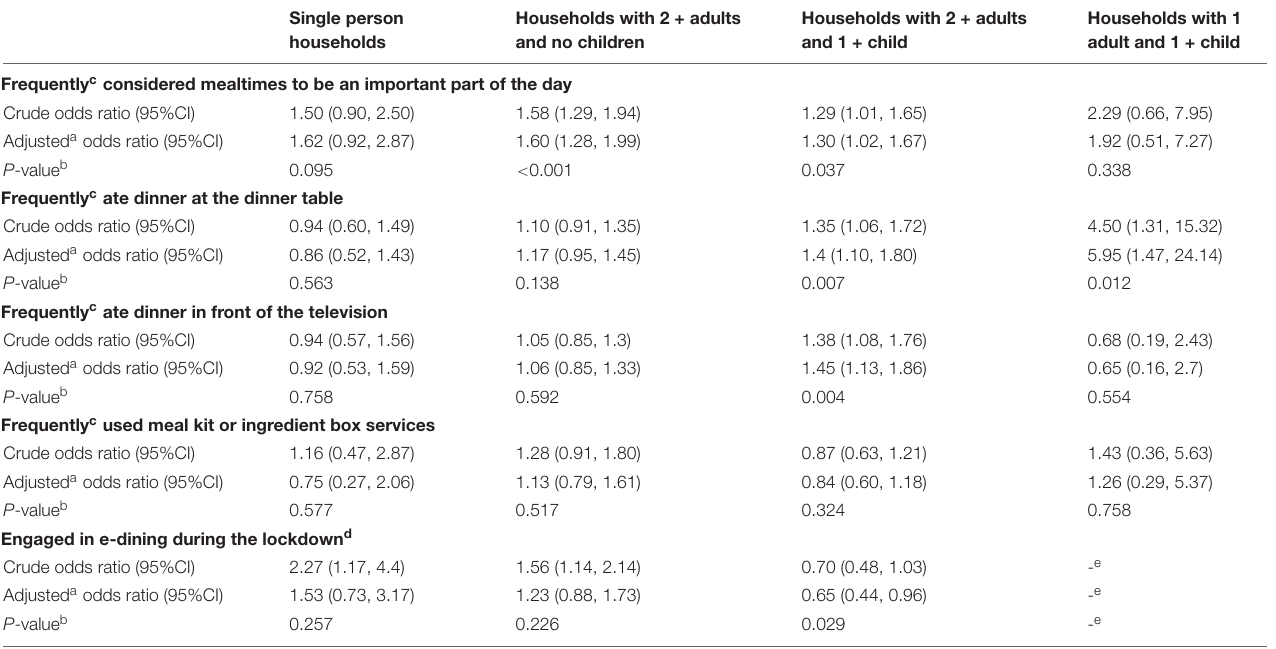
TABLE 7 | The impact of psychological distress during lockdown on mealtime behaviors.